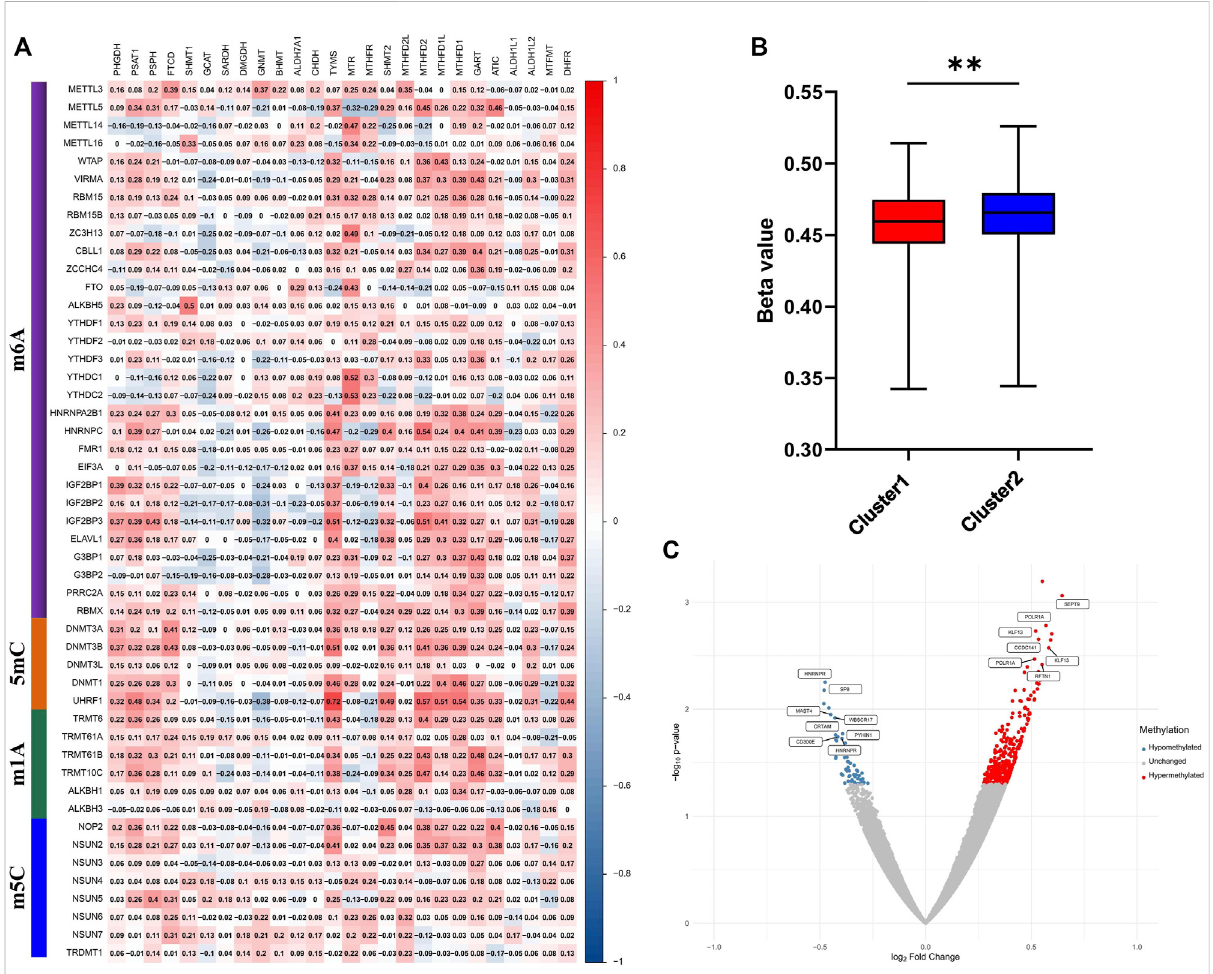
FIGURE 6 Correlationofone-carbonmetabolismassociatedgeneswithmethylation. (A) Correlationof26one-carbonmetabolismassociatedgeneswith 49 methylation enzymes; (B) The difference of methylation level between cluster 1 and cluster 2; (C) Differential analysis of methylation sites between cluster 1 and cluster 2. ** means p <